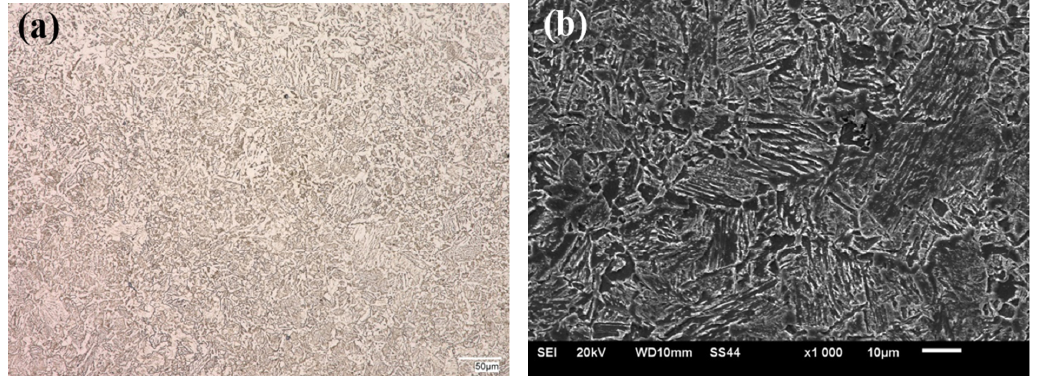
Figure 5. Microstructure of A6 casting, ( a ) OM; ( b ) SEM.